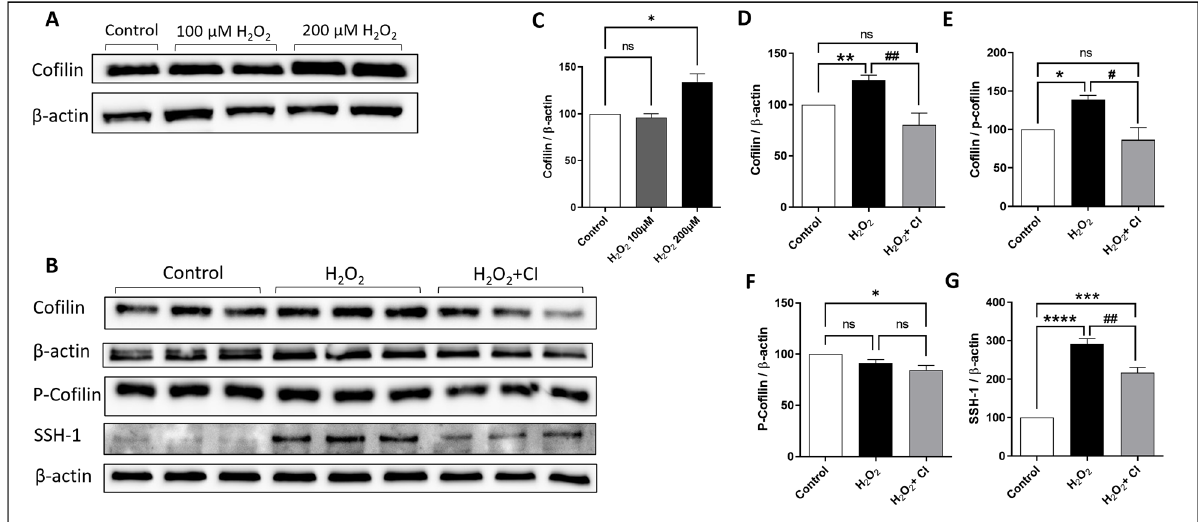
Figure 1. The expression levels of cofilin, p-cofilin, and SSH-1 in response to H 2 O 2 treatment in microglial cells. HMC3 microglial cells were treated with 100 and 200 μ M H 2 O 2 for 24 h, and then, the protein expression level was evaluated by WB. ( A , C ) While there was no change in cofilin expression in the 100 μ M H 2 O 2 treated group, it was significantly upregulated in 200 μ M concentration of H 2 O 2 ; hence, 200 μ M was used for the following experiments. ( B ) Immunoblots of cofilin, p-cofilin and SSH-1 were analyzed by WB. The expression levels of cofilin ( D ), cofilin/p-cofilin ratio ( E ), and SSH1 ( G ) but not p-cofilin ( F ) were significantly increased in the H 2 O 2 group and significantly reduced when treated with CI. Data are expressed as mean ± SEM of three independent experiments where p < 0.05 was considered significant. * p < 0.05, ** p < 0.01, *** p < 0.001, **** p < 0.0001 relative to control group. # p < 0.05, ## p < 0.01 relative to H 2 O 2 group. (See Figure S1 for original Western blot images.)